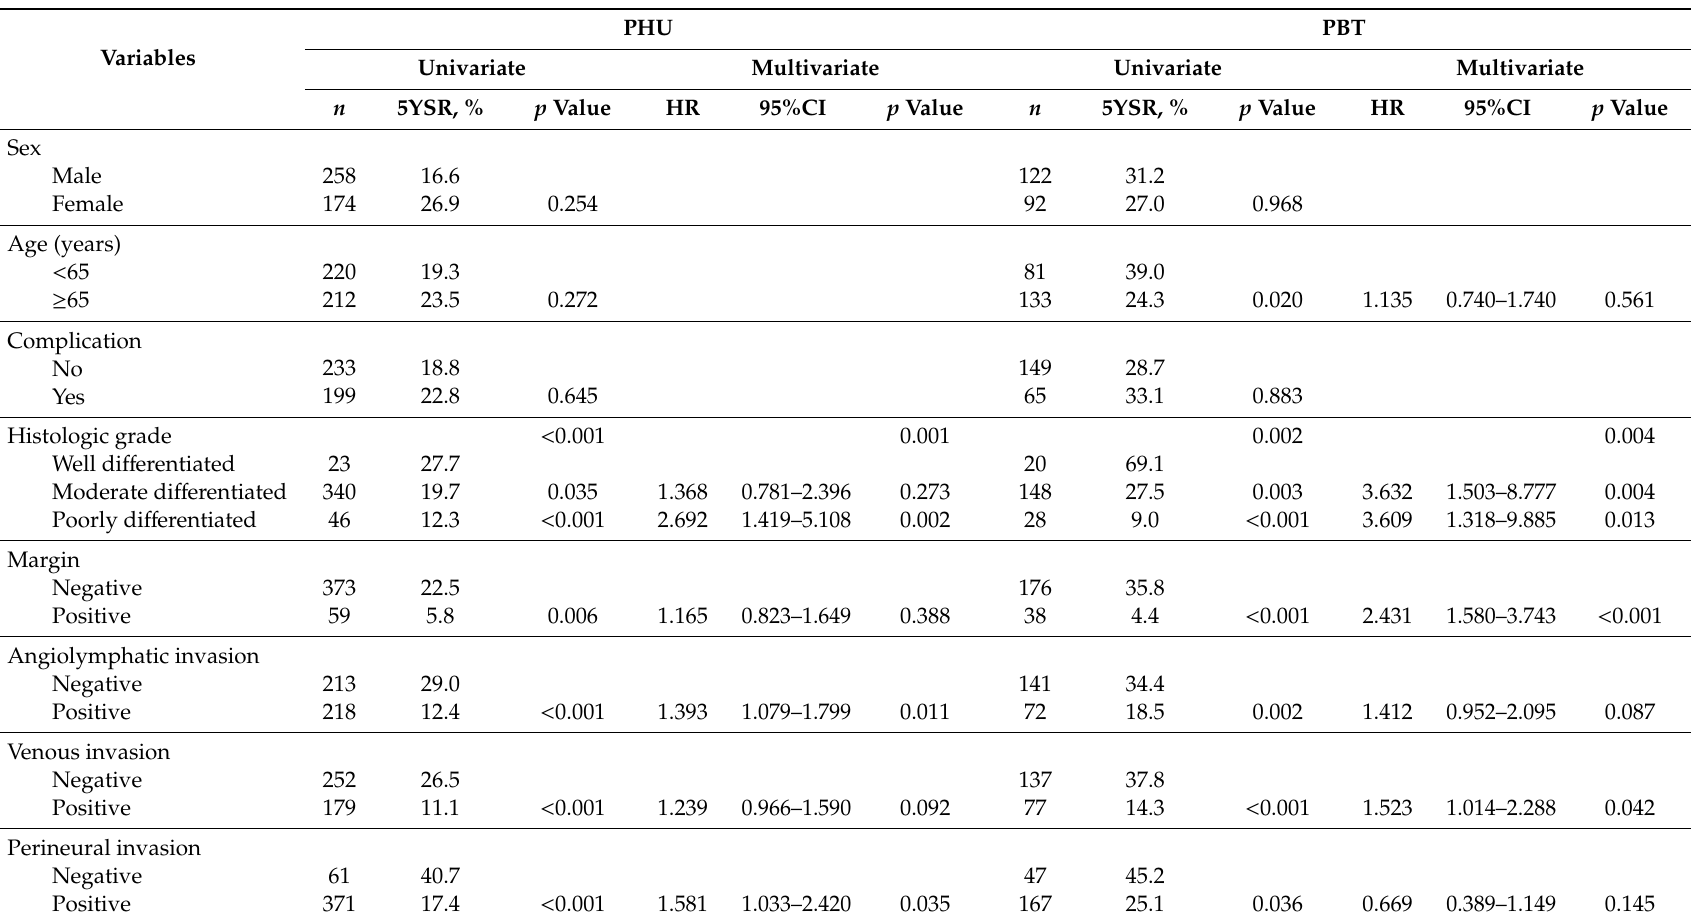
Table 4. Comparison of independent risk factors of pancreatic cancer in PHU and